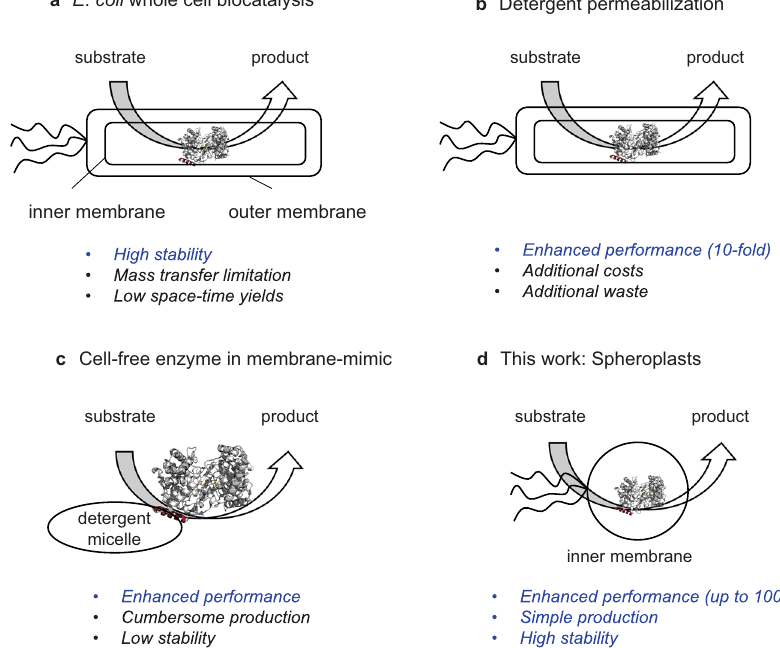
Fig.1|StrategiesappliedinSHCcatalysistoavoidmasstransferissues.a E.coli whole-cellbiocatalysiswithSHCbene fi tsfromthehighstabilityoftheenzymeinits host. However, mass transfer limitations of the membrane hamper the productivity 43 . b Deliberate permeabilization of the cell membrane by